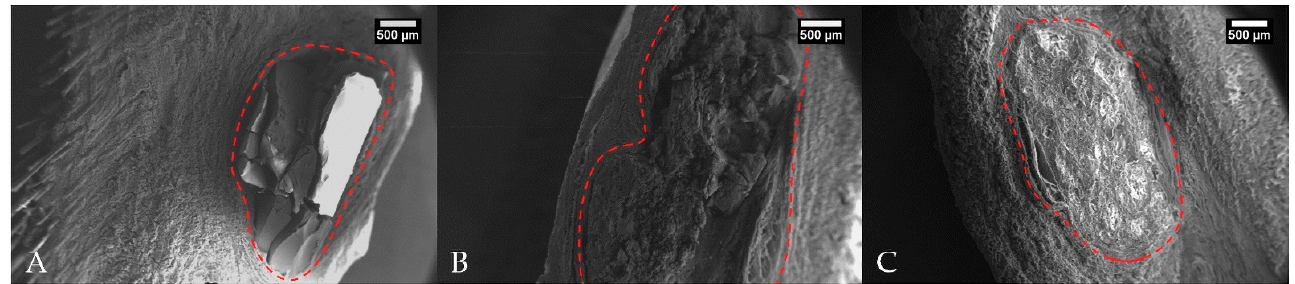
Figure 8. SEM micrographs of skin fragments with PLA implanted in one horse ( A ) 34 weeks following implantation; ( B ) 38 weeks following implantation; and ( C ) 57 weeks following implantation. Dotted red lines delimits the area of the im- plants.